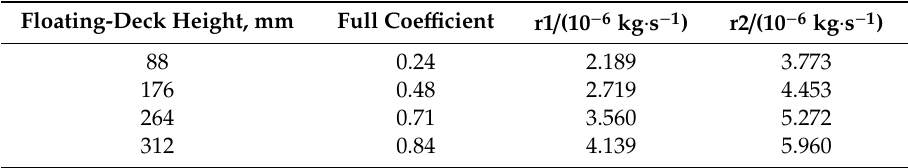
Table 2. Loss rates of n-hexane measured in model tanks